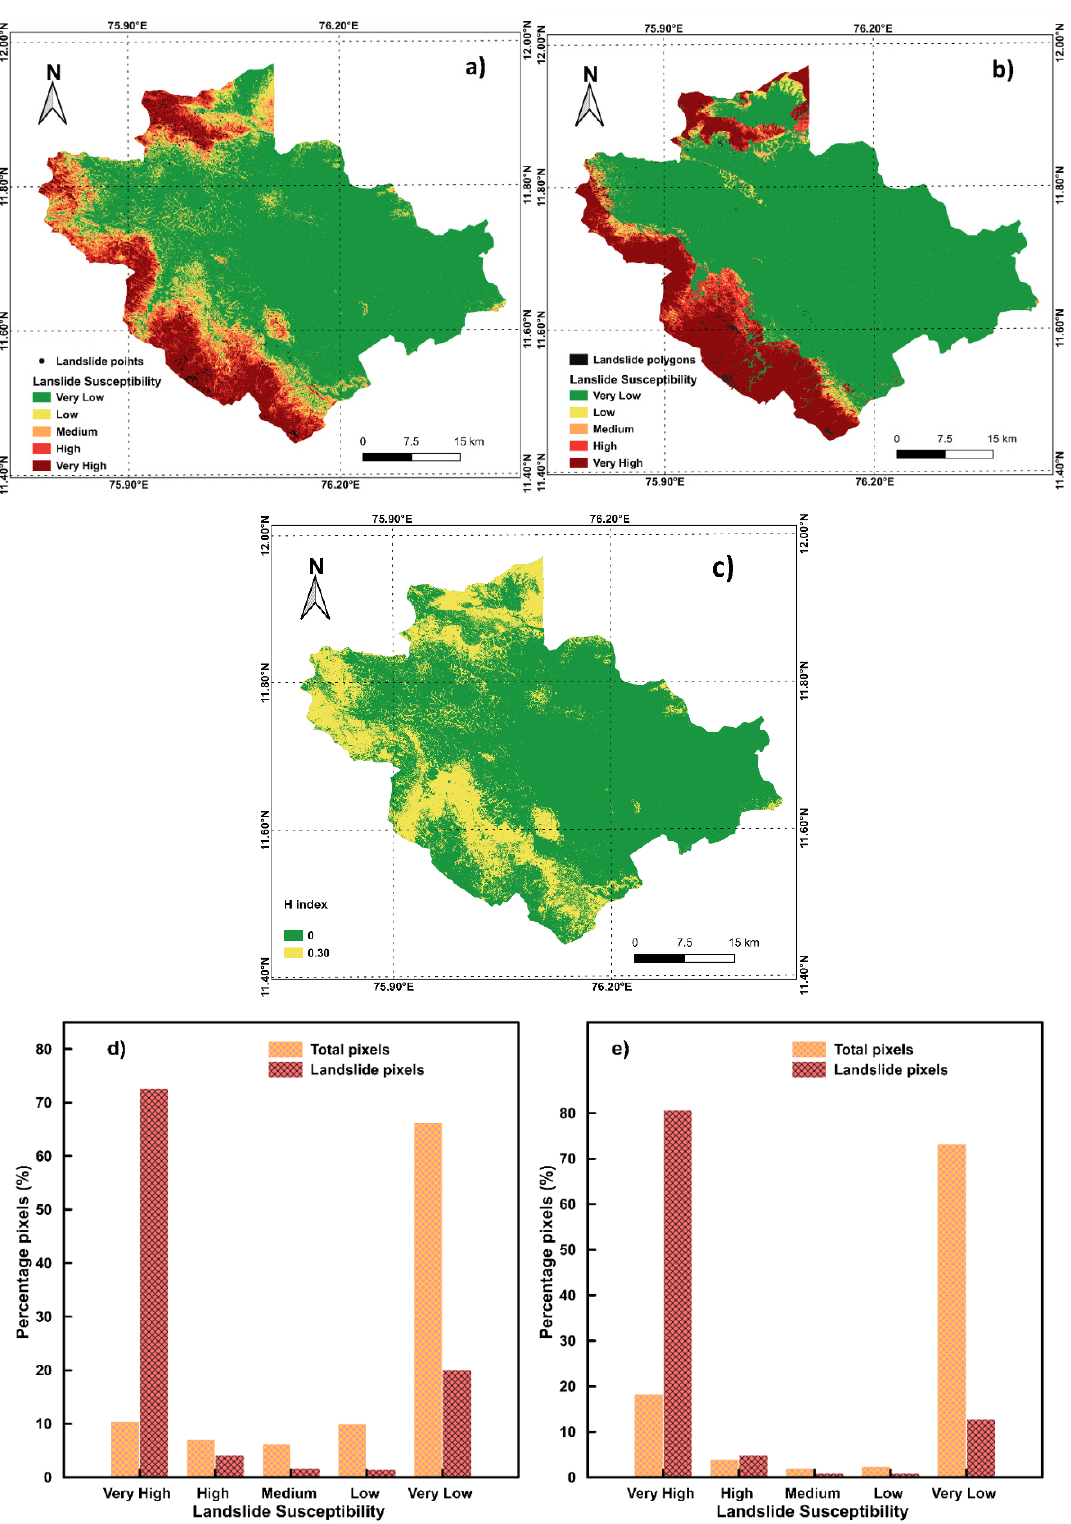
Figure 11. Details of landslide susceptibility maps prepared using SVM algorithm: ( a ) using point data, ( b ) using polygon